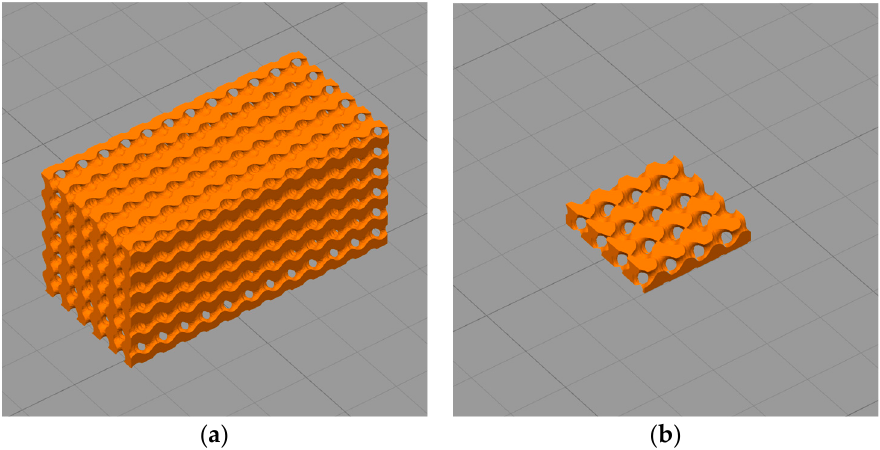
Figure 1. ( a ) Gyroid scaffolds intended for the compressive test, with the 12 mm × 25 mm plane of